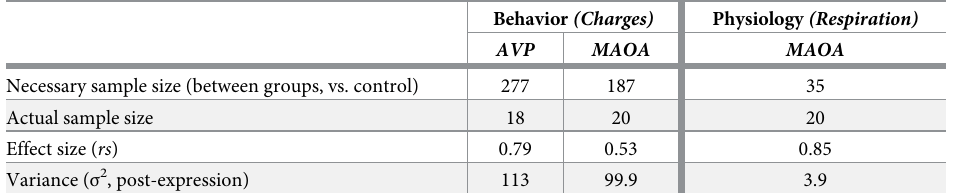
Table 1. Benefit of within-subject experimental design on sample size for behavioral genetic